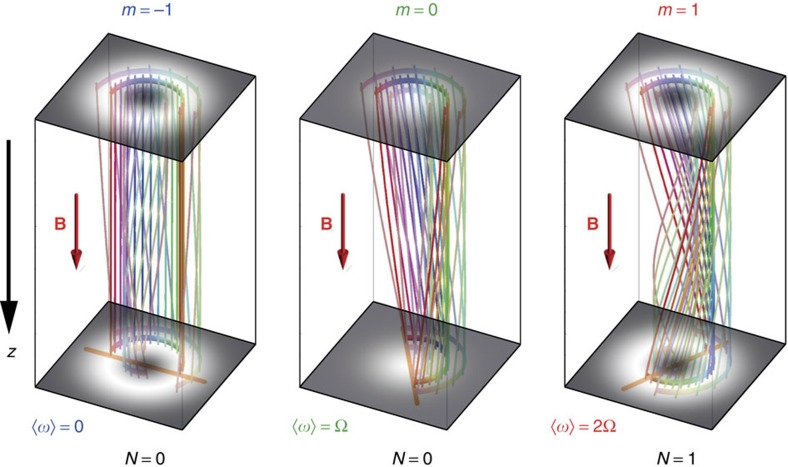
Landau states with different azimuthal indices and electron Bohmian trajectories.Grey-scale plots show the transverse probability distributions |ψ|2 of the states (1) with radial quantum number n=0 and azimuthal numbers m=−1, 0, 1 (which correspond to the Landau levels (2) with N=0, 0, 1). Three-dimensional streamlines of the probability current in equation (3) (that is, Bohmian trajectories) inside these states are shown for three different radii r/wB=0.6, 1, 1.4, in the truncated azimuthal range ϕ|z=0ε(0, π), and for the Larmor propagation distance zε(0, v/Ω) (v is the electron velocity). Different trajectories are marked by different colours for the sake of convenience. The spiralling of the Bohmian trajectories at the maximal-intensity radii  (indicated by the orange lines in the bottom planes) corresponds to the m-dependent internal rotational dynamics with frequencies ‹ω› of equation (4).